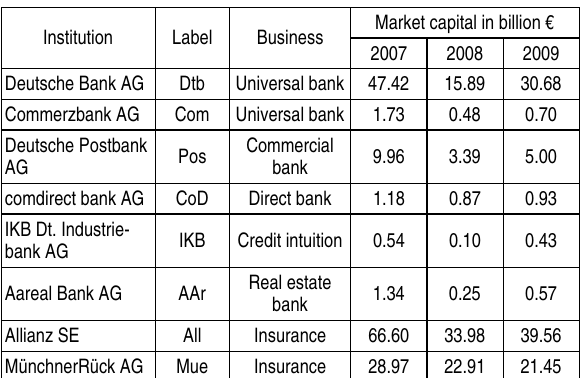
Table 2. Overview of financial institutions (deadline for the capital data was December